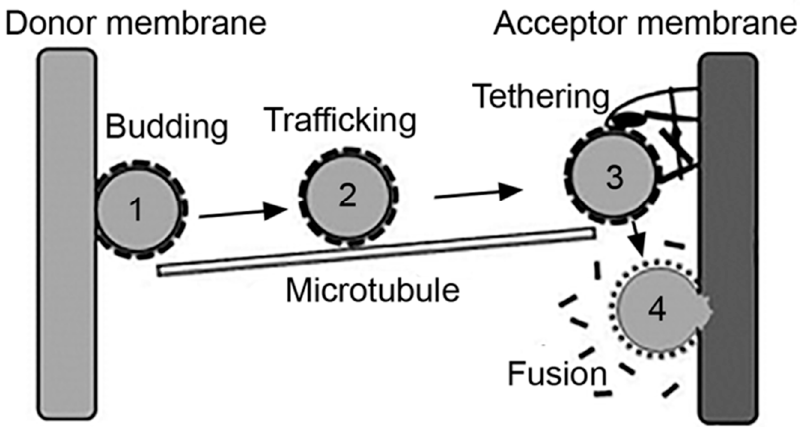
Figure 2. Vesicular transport. Intracellular vesicles transport cargo between the plasmalemma and organelles or from an organelle to another, which encompasses the processes of: ( 1 ) budding of a nascent vesicle from the donor membrane and pinching off into the cytosol; ( 2 ) trafficking aided by cytoskeletal elements; ( 3 ) tethering of the vesicle to the acceptor membrane; and ( 4 ) fusion to deliver cargo to the acceptor compartment. Adapted and reproduced with permission from Figure 3.2 in [2].